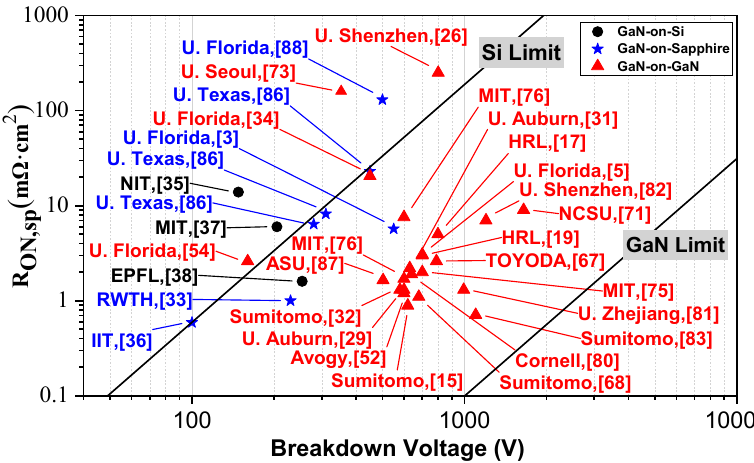
Figure 2. Benchmarks of the R ON,sp vs. breakdown voltage (BV) of vertical SBDs with GaN on Si, sapphire, and GaN substrates.